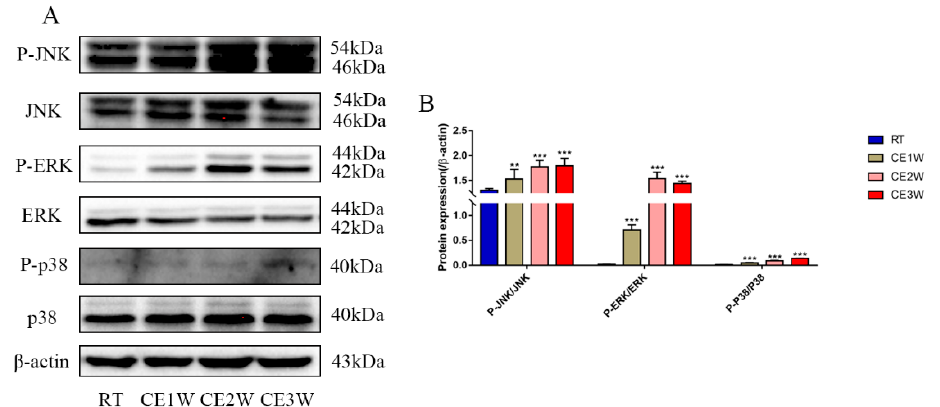
Figure 6. The expressions of MAPK signaling pathway components in hippocampal lysates as assessed by Western blotting and relative density analyses. ( A ) JNK, phospho-(P-) JNK (Thr183/Tyr185), ERK, P-ERK (Thr202/Tyr204), p38, P-p38 (Thr180/Tyr182), and β -actin (control) expressions. The relevant kinase expressions were analyzed and shown as graphs ( B ) in each group. Data were between RTM vs. CE1W, CE2W, and CE3W groups and were analyzed by one-way analysis of variance. The results are expressed as the mean ± SD ( n = 6) of four independent groups. ** p < 0.01; *** p < 0.001.